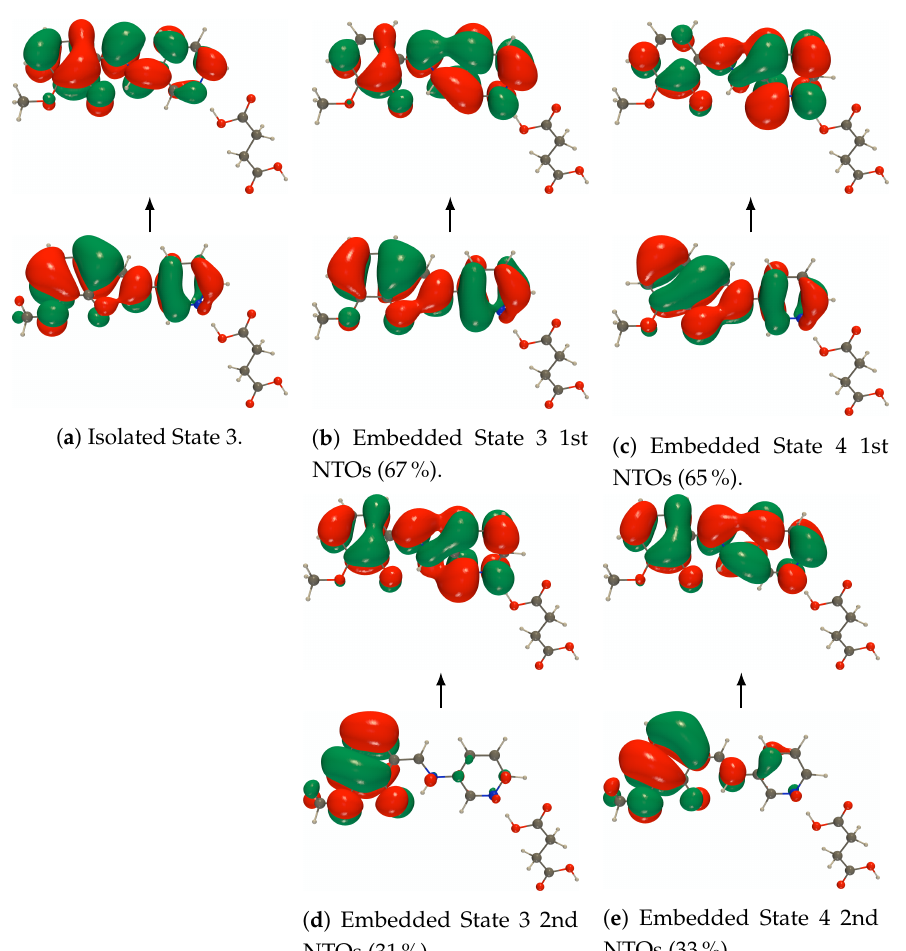
Figure 8. RI-CC2/def2-TZVPD NTOs (holes below the arrows and particles above them, the red (green) lobes are the positive (negative) ones) of the 3rd isolated keto form of PYV3 + SA [PYV3 · SA] and of the 3rd and 4th excited states of the embedded one (isovalue of